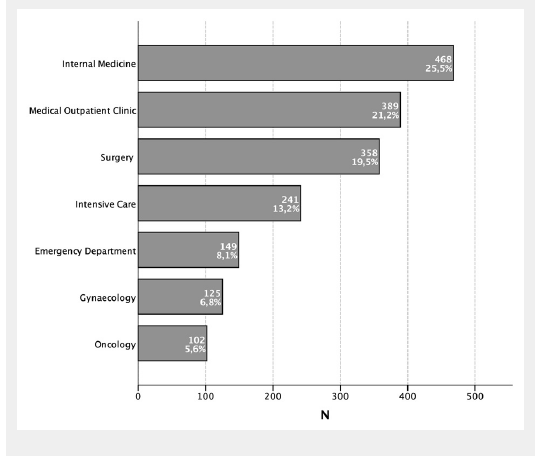
Figure 1 Distribution of all red blood cell units transfused in a period of 15 months.